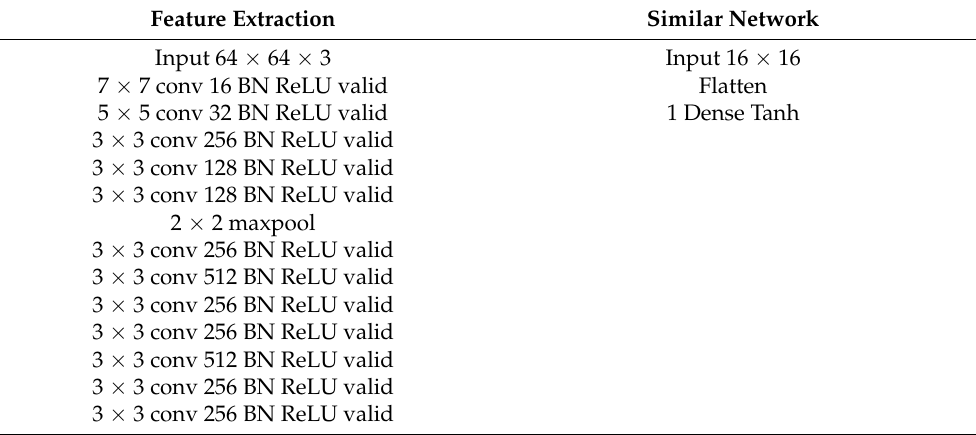
Table 2. Network architecture.